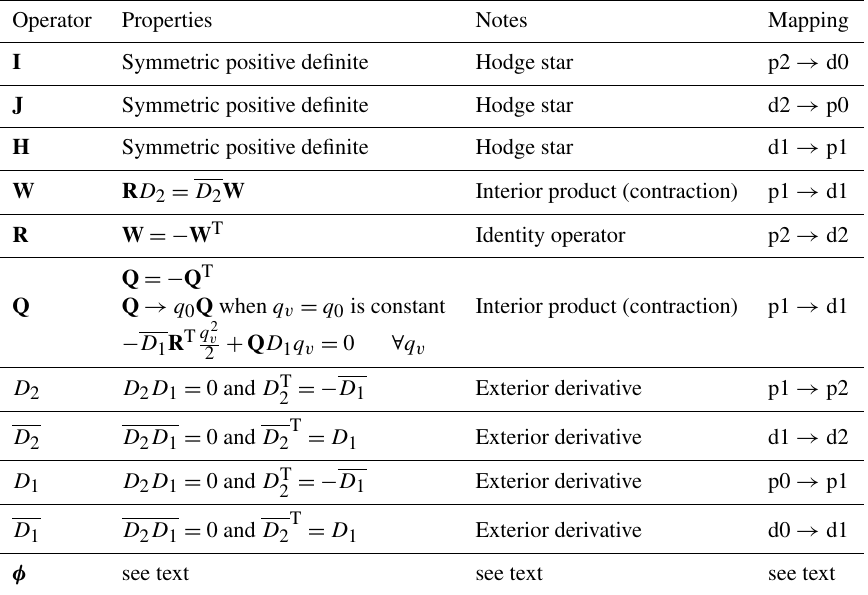
Table 1. Summary of required operator properties for obtaining the desirable mimetic properties along with total energy and potential enstrophy conservation. A example of operators that satisfy these properties can be found in Appendix C. More details can be found in Thuburn and Cotter (2012) or Eldred (2015). Note that the mapping column indicates which types of quantities the operator accepts as inputs, and what it produces as output, with “p” or “d” denoting the primal and dual grids; while the number (0,1,2) denotes the geometric entity the quantity is integrated over. For example, the R operator takes as input quantities integrated over primal grid cells, and produces as output quantities integrated over dual grid